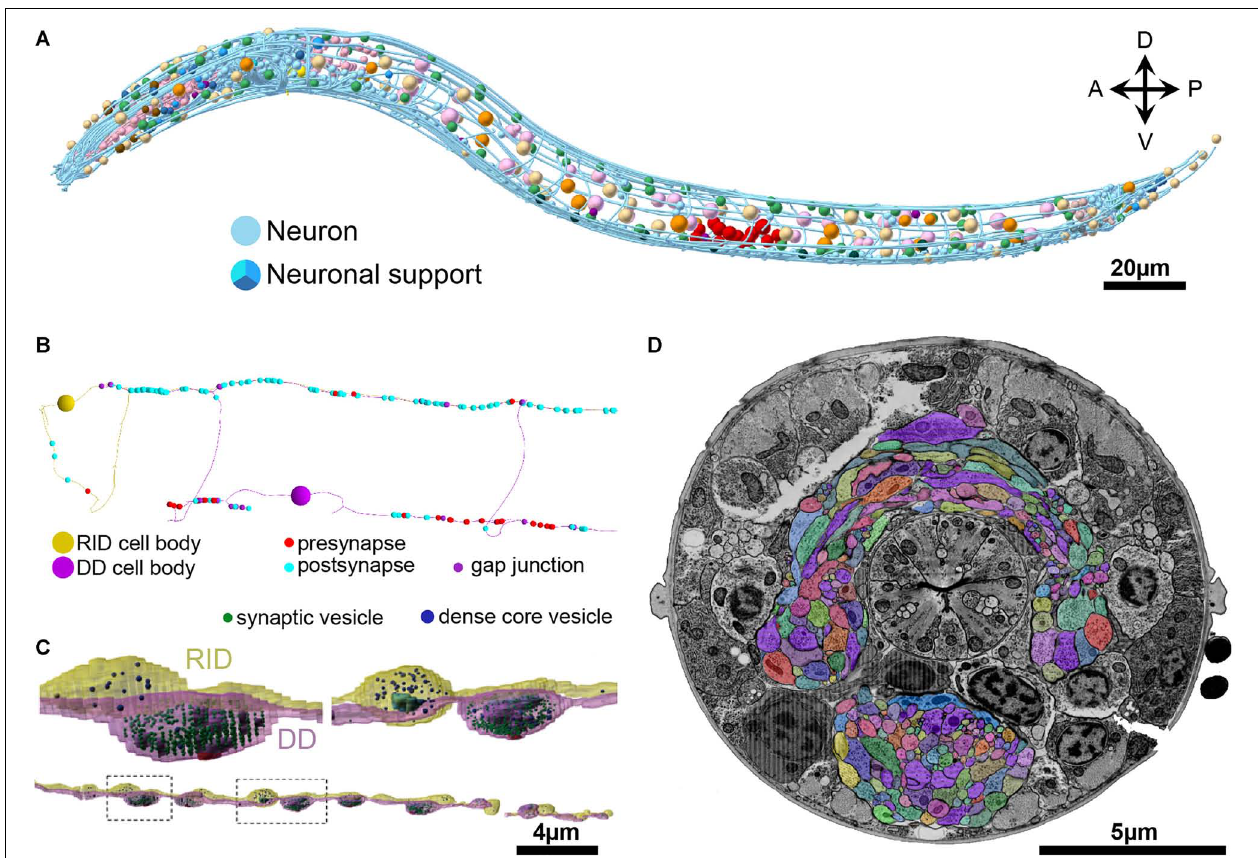
FIGURE 5 | Skeleton and volumetric reconstruction of the C. elegans nervous system. (A) A complete reconstruction of all nuclei (round balls) and all neuronal processes (blue cables) of a first larval stage C. elegans , achieved through skeleton tracing in CATMAID, and visualized with Blender. (B) A skeleton reconstruction of anterior DD-type motor neurons and the neuromodulatory neuron RID generated using CATMAID. Synaptic input and output are indicated by cyan and red spheres, respectively, and putative gap junctions in marked in dark purple. (C) Volumetric segmentation of part of a DD motor neuron and RID using TrakEM2, with intracellular ultrastructure segmented. (D) A cross-section of an L1 larva. Its nerve ring was fully reconstructed by volumetric segmentation. These segmentation profiles were generated by expanding skeleton seeds to a membrane probability map, followed by manual proofreading in